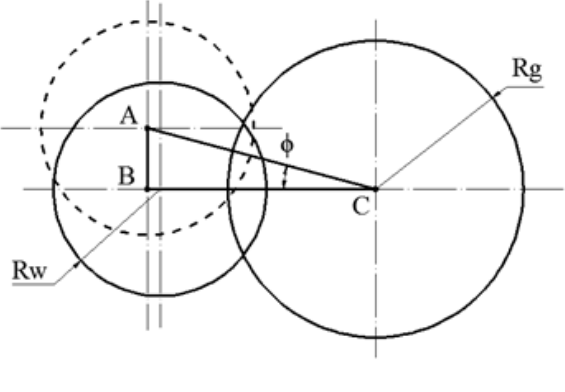
Fig. 2. The vertical motion of the roll